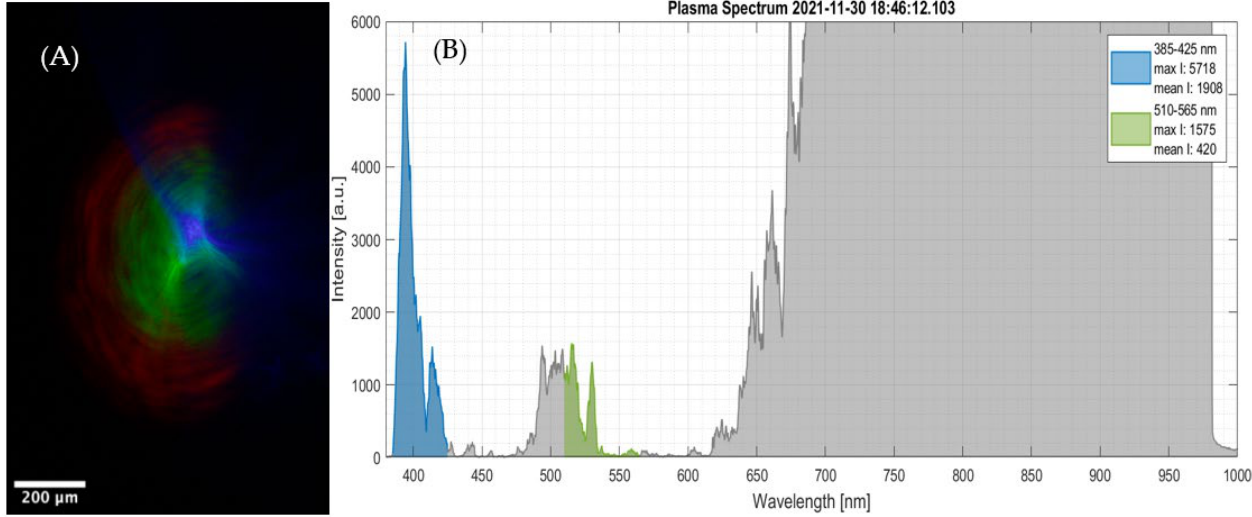
Figure 15. Example of plasma imaging raw picture ( A ) with 3.1 magnification where the laser beam is in the right/left direction and ( B ) example of plasma optical spectrum. The blue and green components represent the second harmonic emission and the two-plasmon decay .